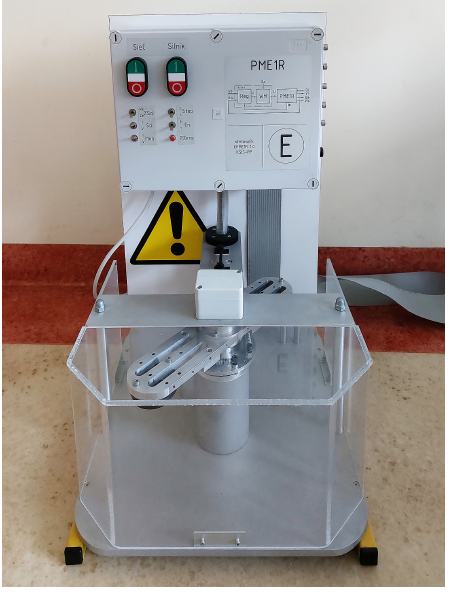
Figure 10. Planar PME1R manipulator with a single degree of freedom.